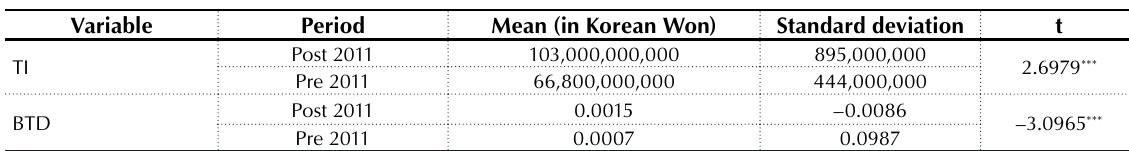
Panel A. Regression